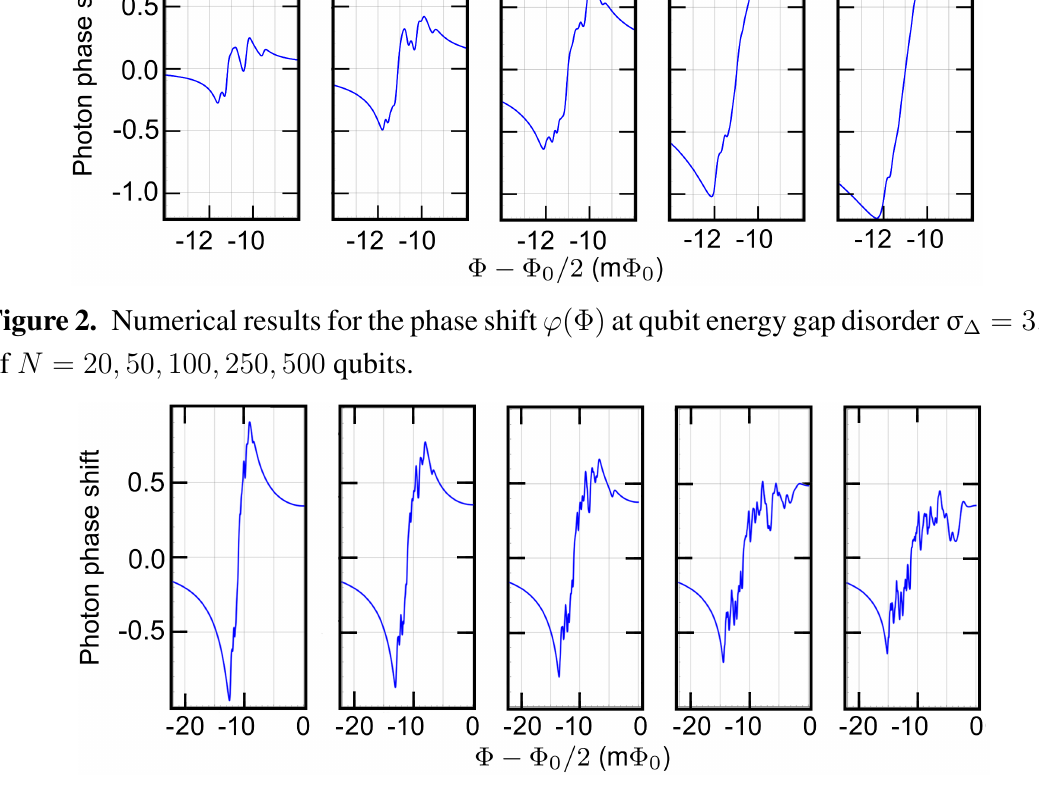
Figure 3. Numerical results for the phase shift ϕ (Φ) of N = 250 qubits using five different = 5 , 7 . 5 , 10 , 15 , 25% . Parameters of the system: probe frequency values of disorder σ ∆ ω / 2 π = ω / 2 π = 7 . 78 GHz and relaxation rate κ/ 2 π = 715 kHz, average excitation gap r ∆ / 2 π = 5 . 9 GHz of qubits with normal distribution and dispersion σ = 3 . 6% , average ∆ = 1% , decoherence Γ / 2 π = 33 MHz, coupling constant g/ 2 π = 1 . 1 MHz with σ g ϕ = 74 persistent current I p